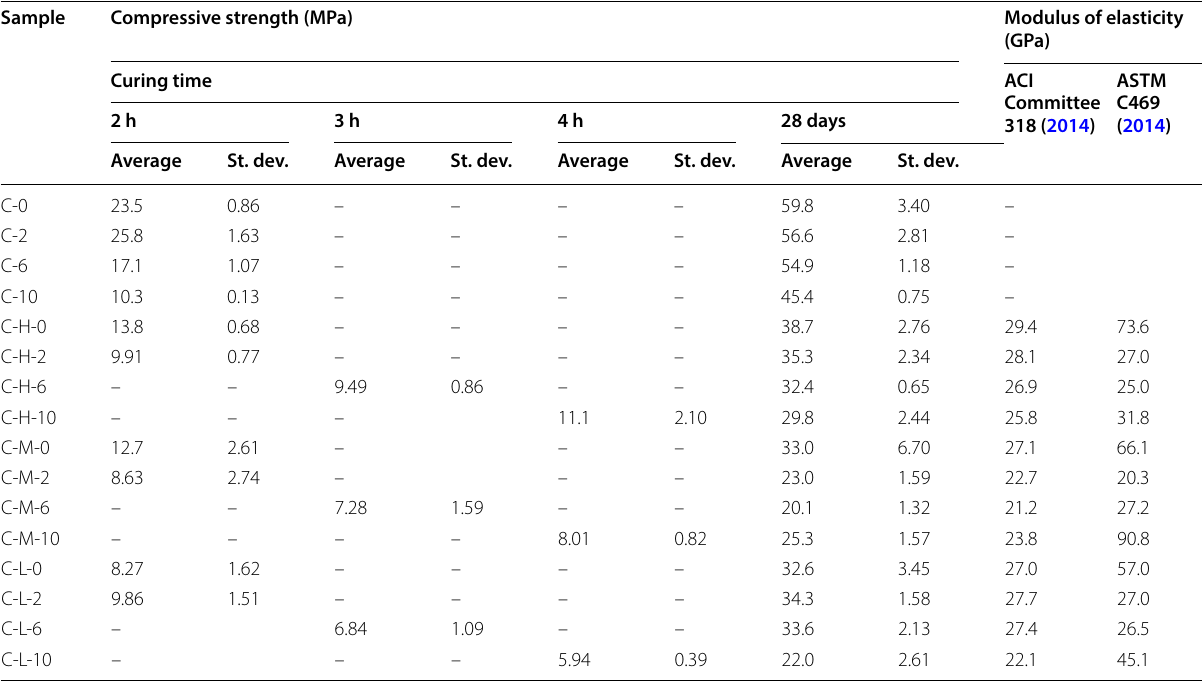
Table 5 Compressive strength and modulus of elasticity.